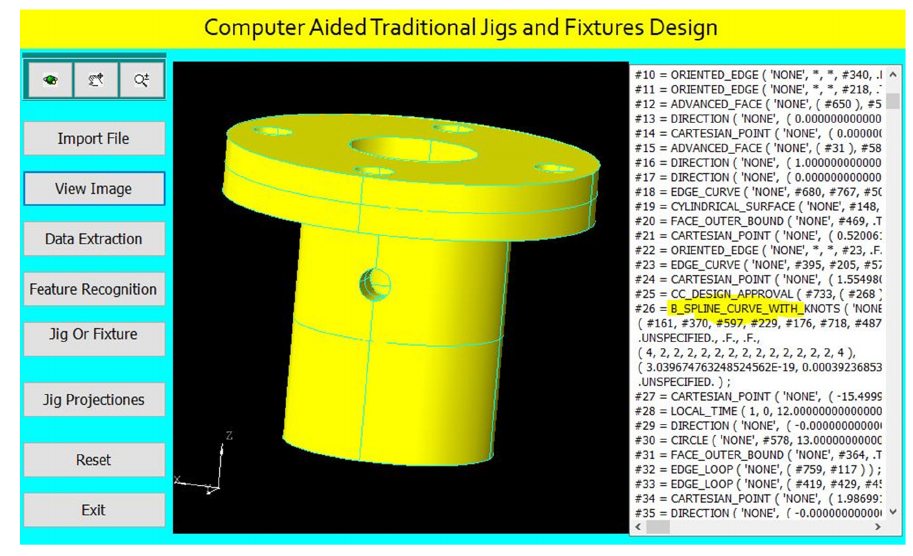
Figure 18. STEP-AP203 file of the part.